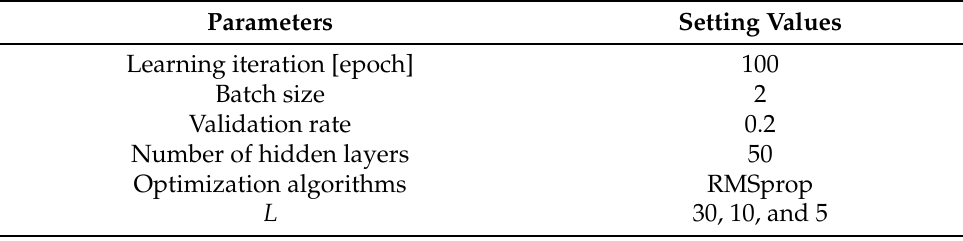
Table 11. Major LSTM parameters and their setting